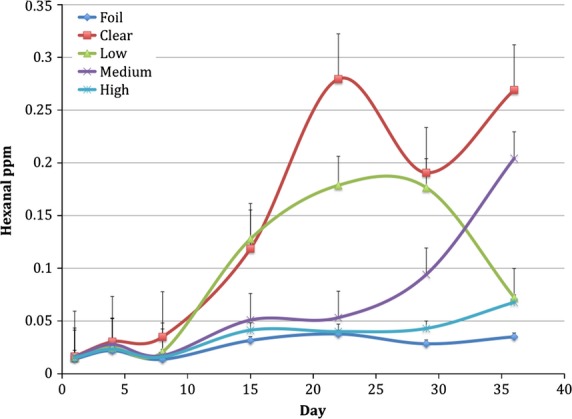
Hexanal concentration in packaging treatments, Low (0.6% TiO2), Med (1.3% TiO2), and High (4.3% TiO2), compared to foil-wrapped and clear packaging over a 36-day period.1 Average of data in both block A and B. 1Exposure to light in hours: day 1 = 23.5, day 4 = 84, day 8 = 191, day 15 = 359, day 22 = 527, day 29 = 696, day 36 = 864.